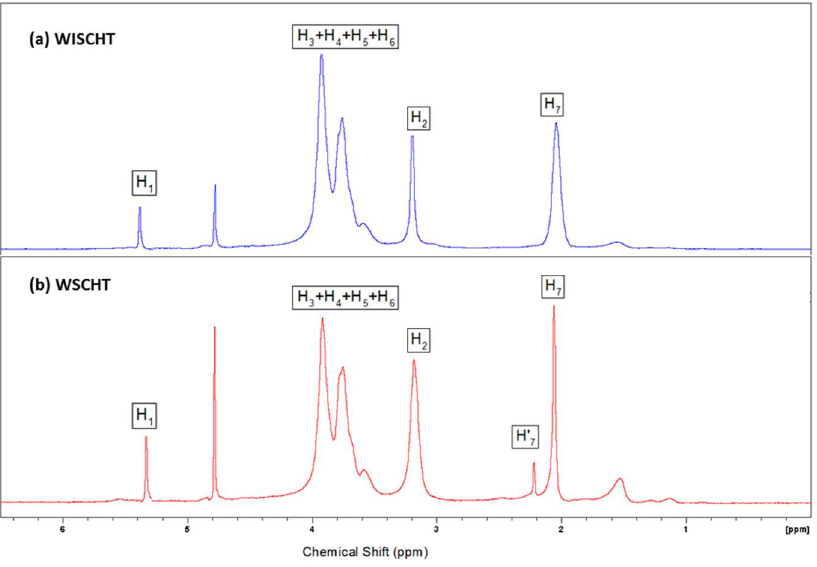
Figure 3. 1 H NMR spectra of ( a ) W IS CHT and ( b ) W S CHT.